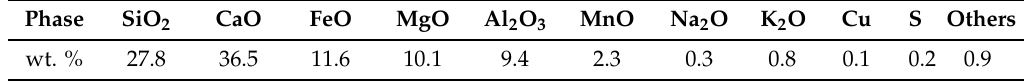
Table 9. Chemical composition of the slag.